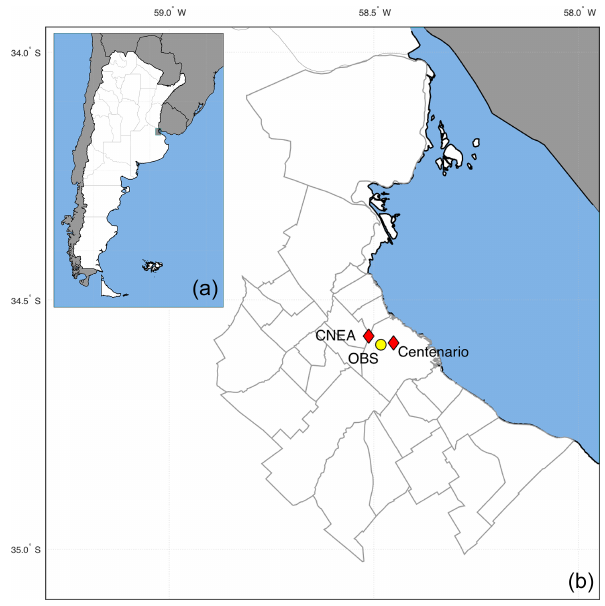
Figure 1. Location of the MABA in Argentina (a) . A magnified view of the MABA (b) . In yellow, the location of OBS, the site of the Argentine National Weather Service monitoring site referred to in this study, and, in red, the air quality monitoring sites (shapefiles from IGN, 2021) are